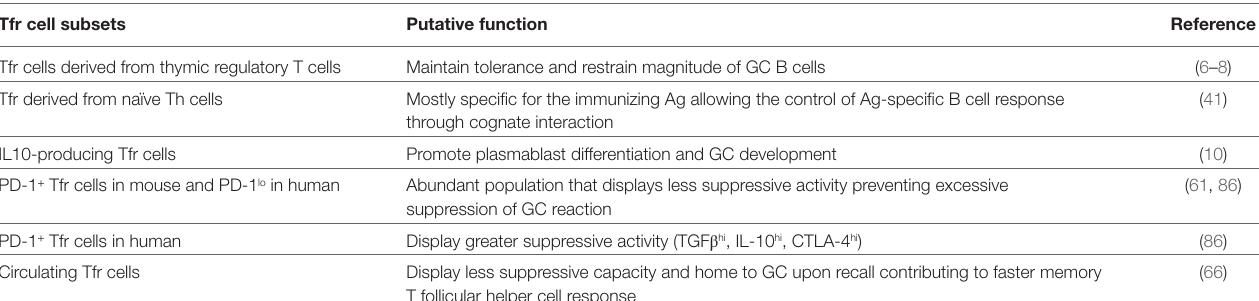
Table 2 | List of the different T follicular regulatory (Tfr) cell subsets and their putative functions. Tfr cell subsets Putative